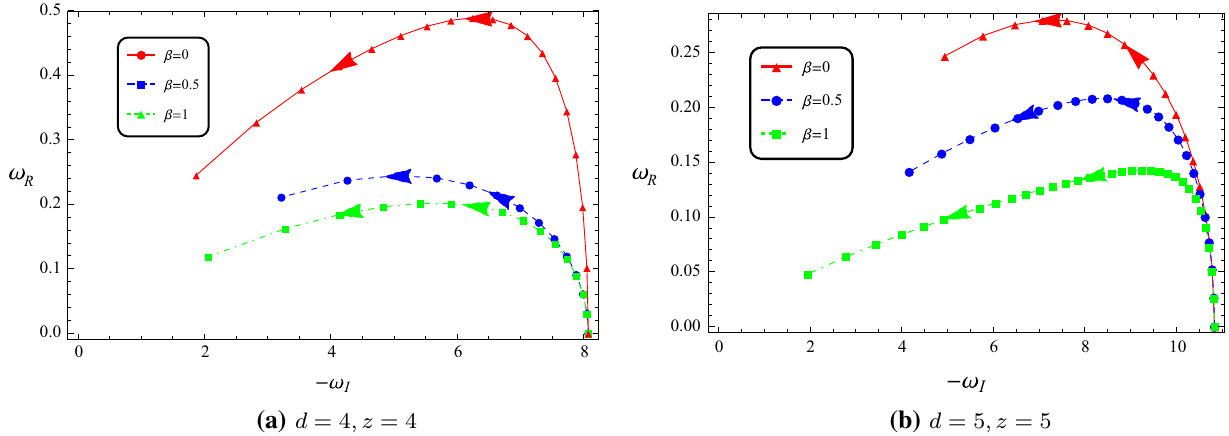
Fig. 2 The behaviors of real and imaginary parts of QNFs in the case with d = z , m 2 s = 1 / 4 and q s = 1 . 5 for different β . The increase of the black holes charge q from 0 to near the extreme value in steps of 0 . 2 are shown with the arrows. Note that for each curve the extreme value of q is